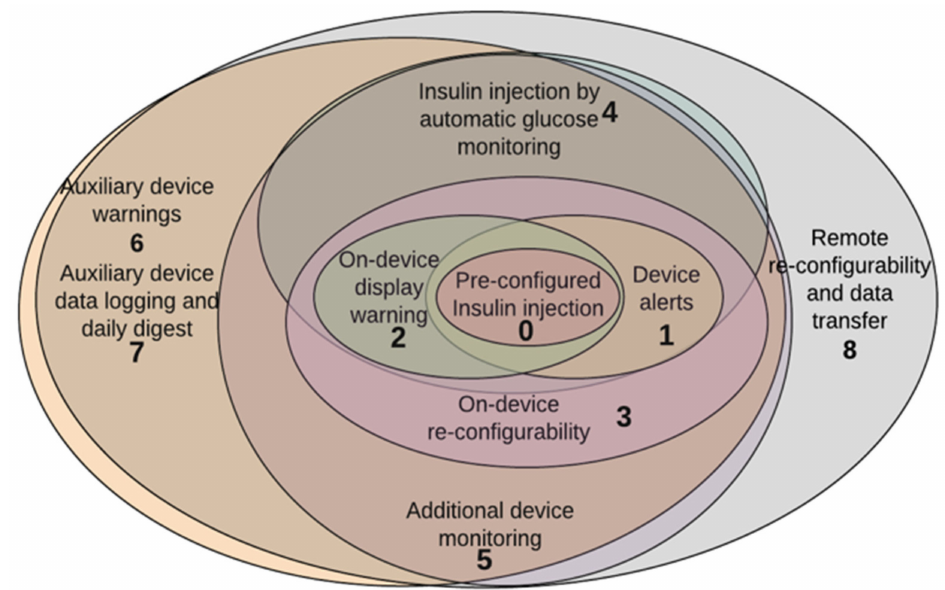
Figure 6. High-level multimodal design of a smart connected insulin